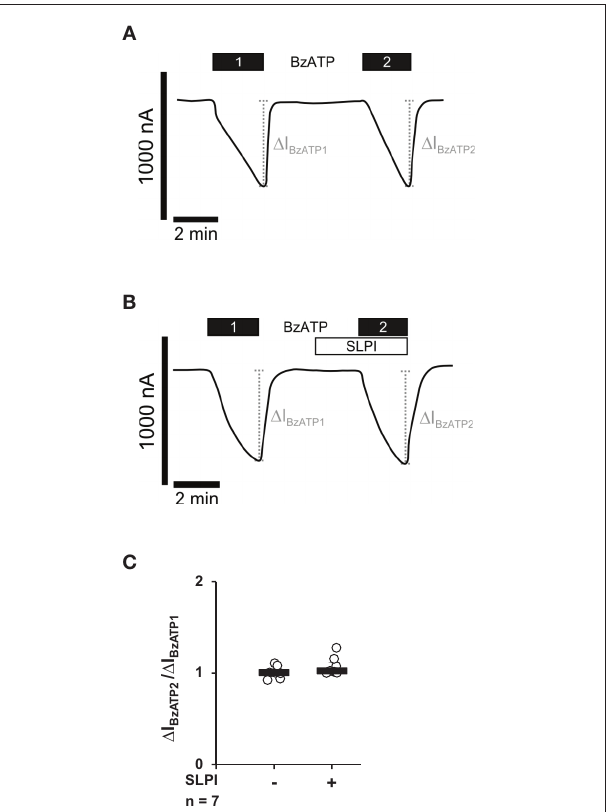
FIGURE 4 | SLPI does not directly modulate the ion channel function of heterologously expressed P2X 7 receptors (P2X 7 Rs). Whole-cell two-electrode voltage-clamp measurements (TEVC) were performed on Xenopus laevis oocytes that heterologously expressed human P2X 7 Rs. (A) Stimulation with 2 ′ (3 ′ )-O-(4-benzoylbenzoyl)adenosine 5 ′ -triphosphate triethylammonium salt (BzATP; 10 µ M) induced repetitive changes in transmembrane ion currents ( 1 I BzATP1 and 1 I BzATP2 ). (B) Application of SLPI (10 µ g/ml) had no impact on 1 I M and did not impair the consecutive response to BzATP. (A,B) Representative current curves are shown. (C) Graphical representation of normalized 1 I BzATP2 / 1 I BzATP1 are shown (A,B) . Experimental groups were compared by Wilcoxon signed-rank